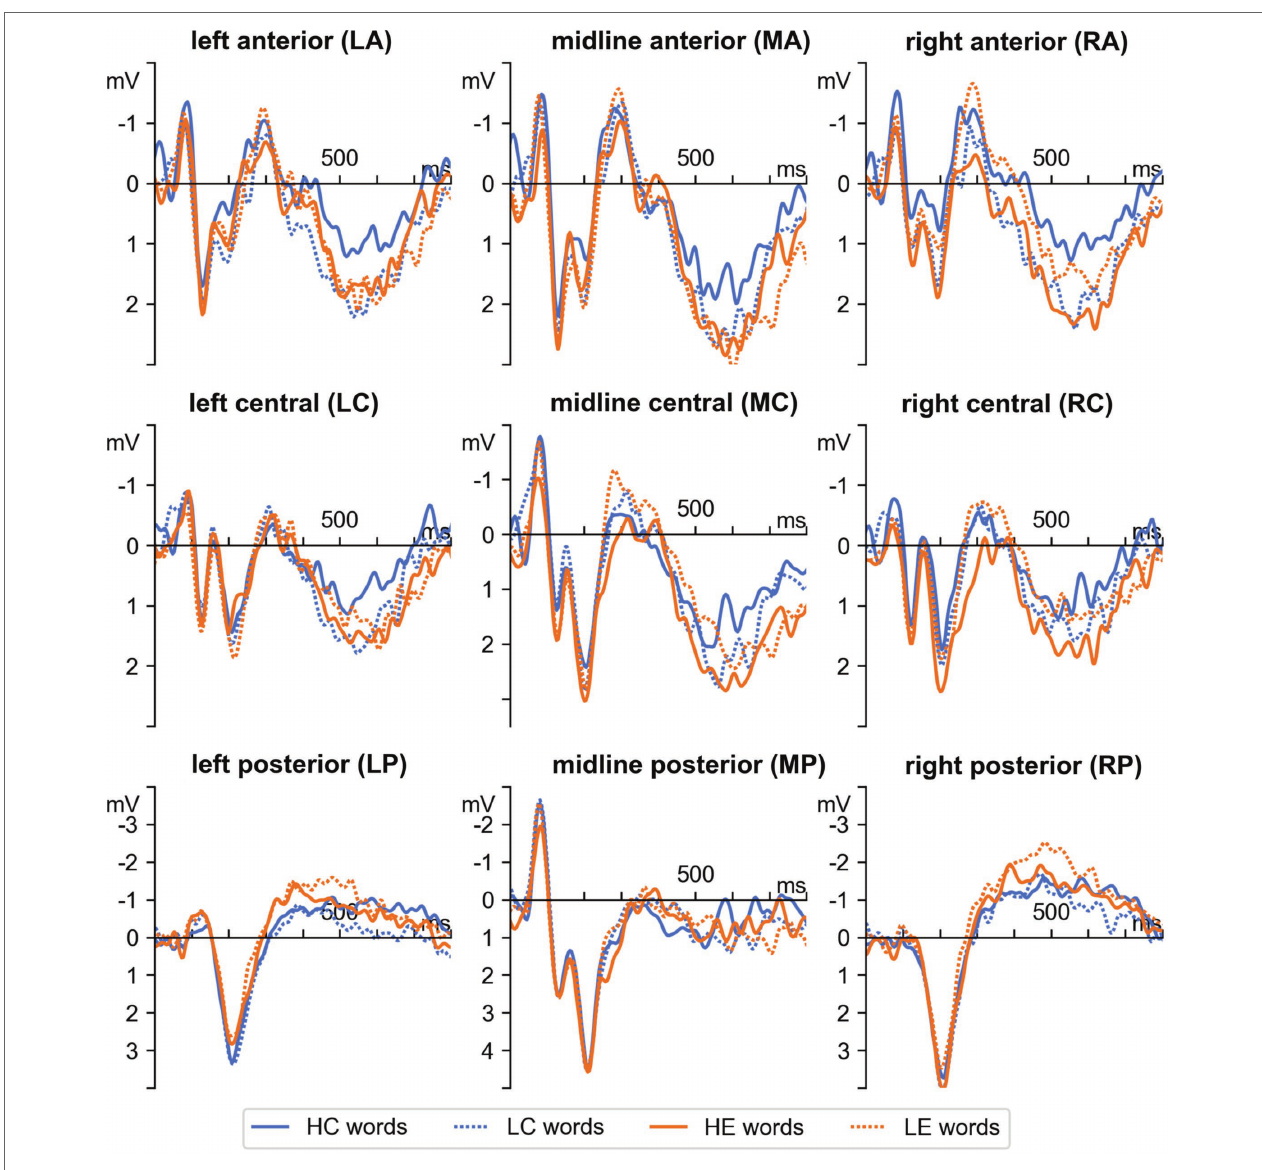
FIGURE 4 | Grand average ERPs for four conditions across all 9 regions of